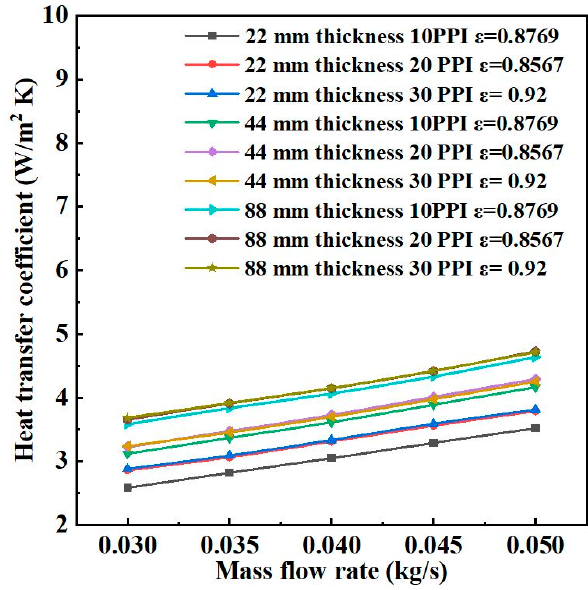
Figure 10. Variation of heat transfer coefficient for different mass flow rates for different PPI and different thickness.